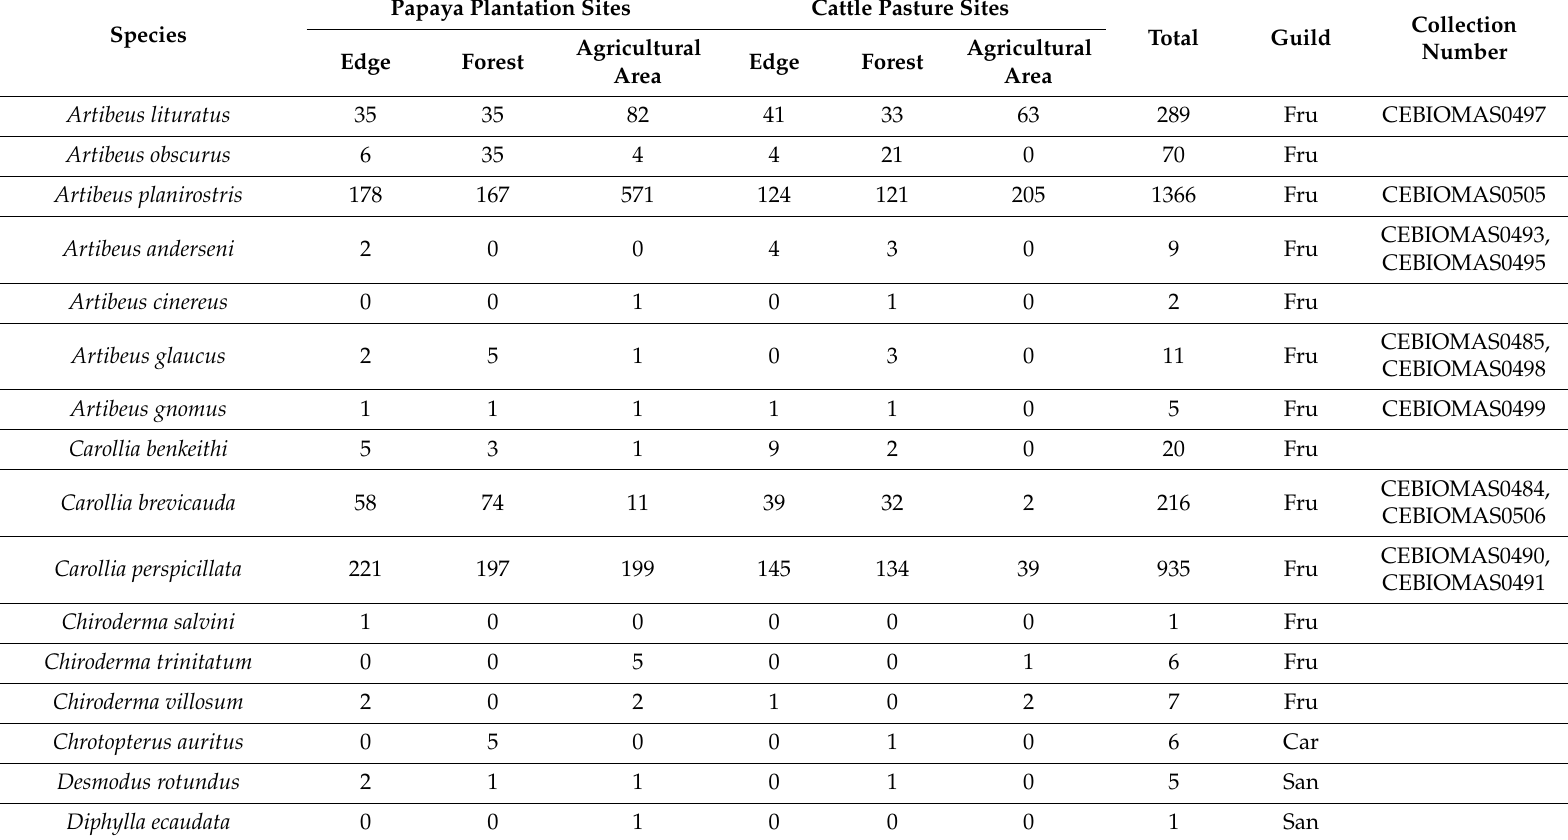
Table 1. Individuals captured for all species registered and specimens collected during the present study. (HCIns) highly cluttered space gleaning insectivores, (Car) highly cluttered space gleaning carnivores, (San) highly cluttered space gleaning sanguivores, (Fru) highly cluttered space gleaning frugivores, (Nec) highly cluttered space gleaning nectarivores, (Omn) highly cluttered space gleaning